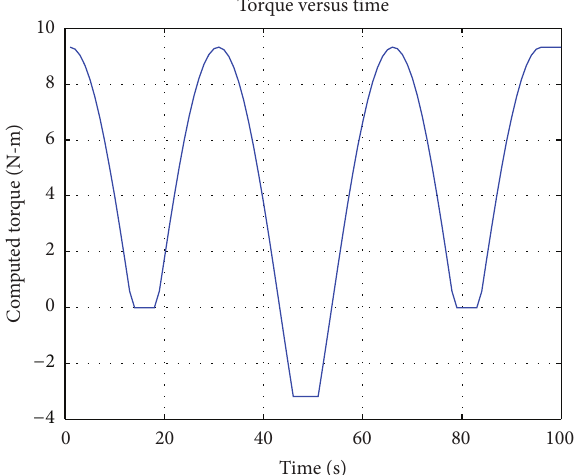
Figure 22: Joint torque graph at shoulder due to flexion and extension.